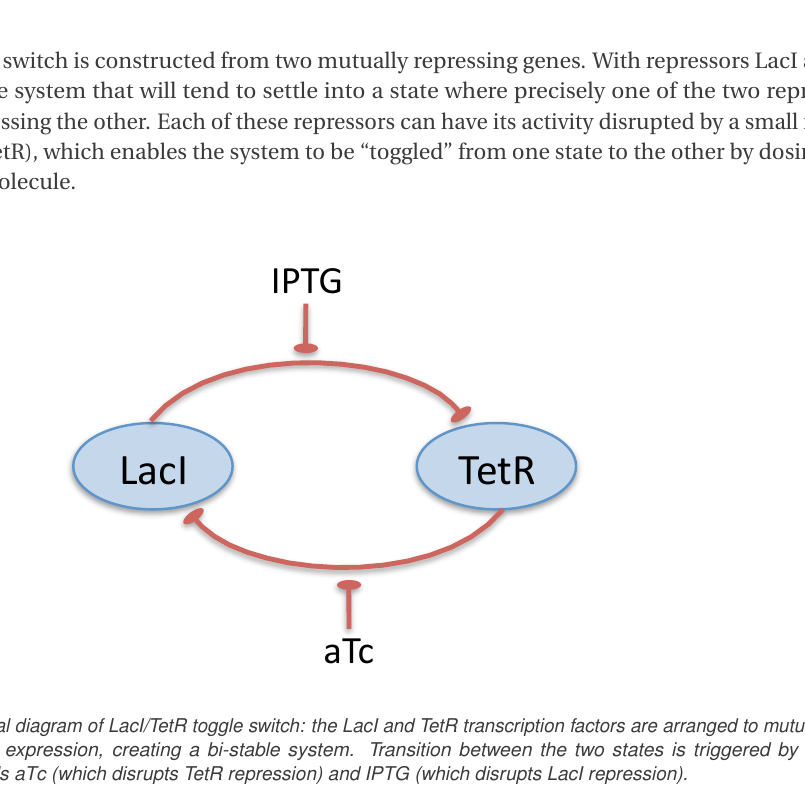
The LacI/TetR toggle switch is modeled in SBOL as two parallel hierarchies of structure and function. The structural 10 hierarchy of the toggle switch is represented using ComponentDefinition s: